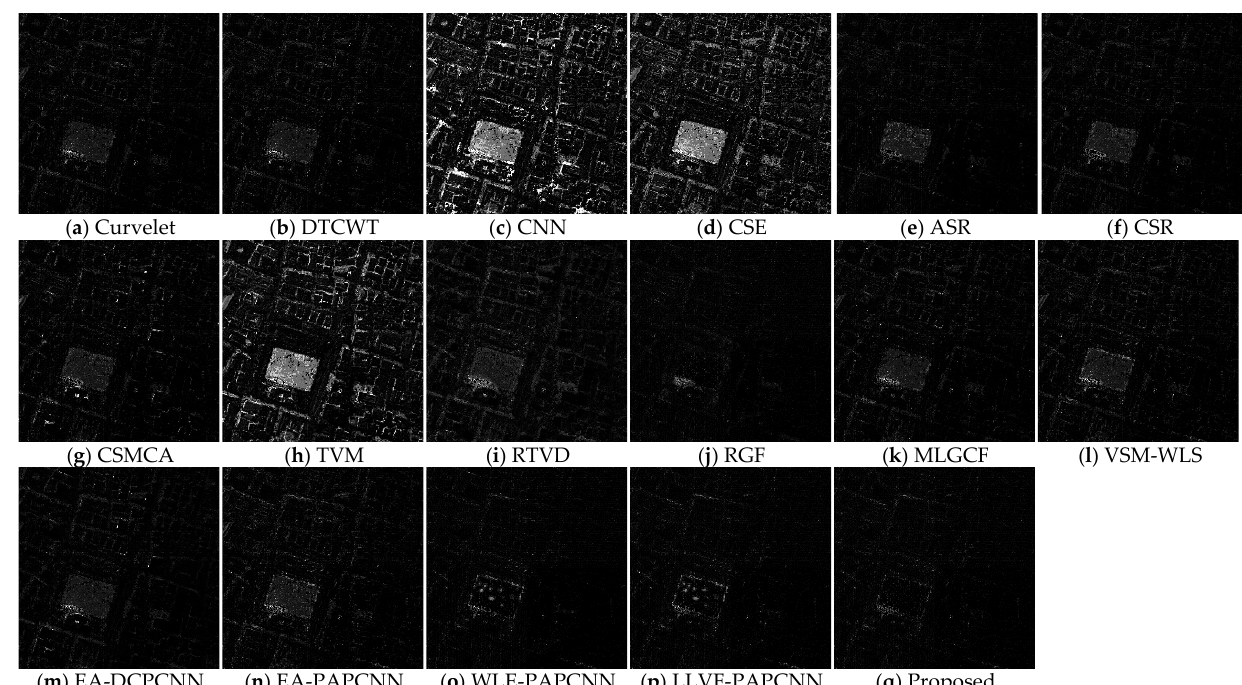
Figure 6. Error images corresponding to QuickBird images.